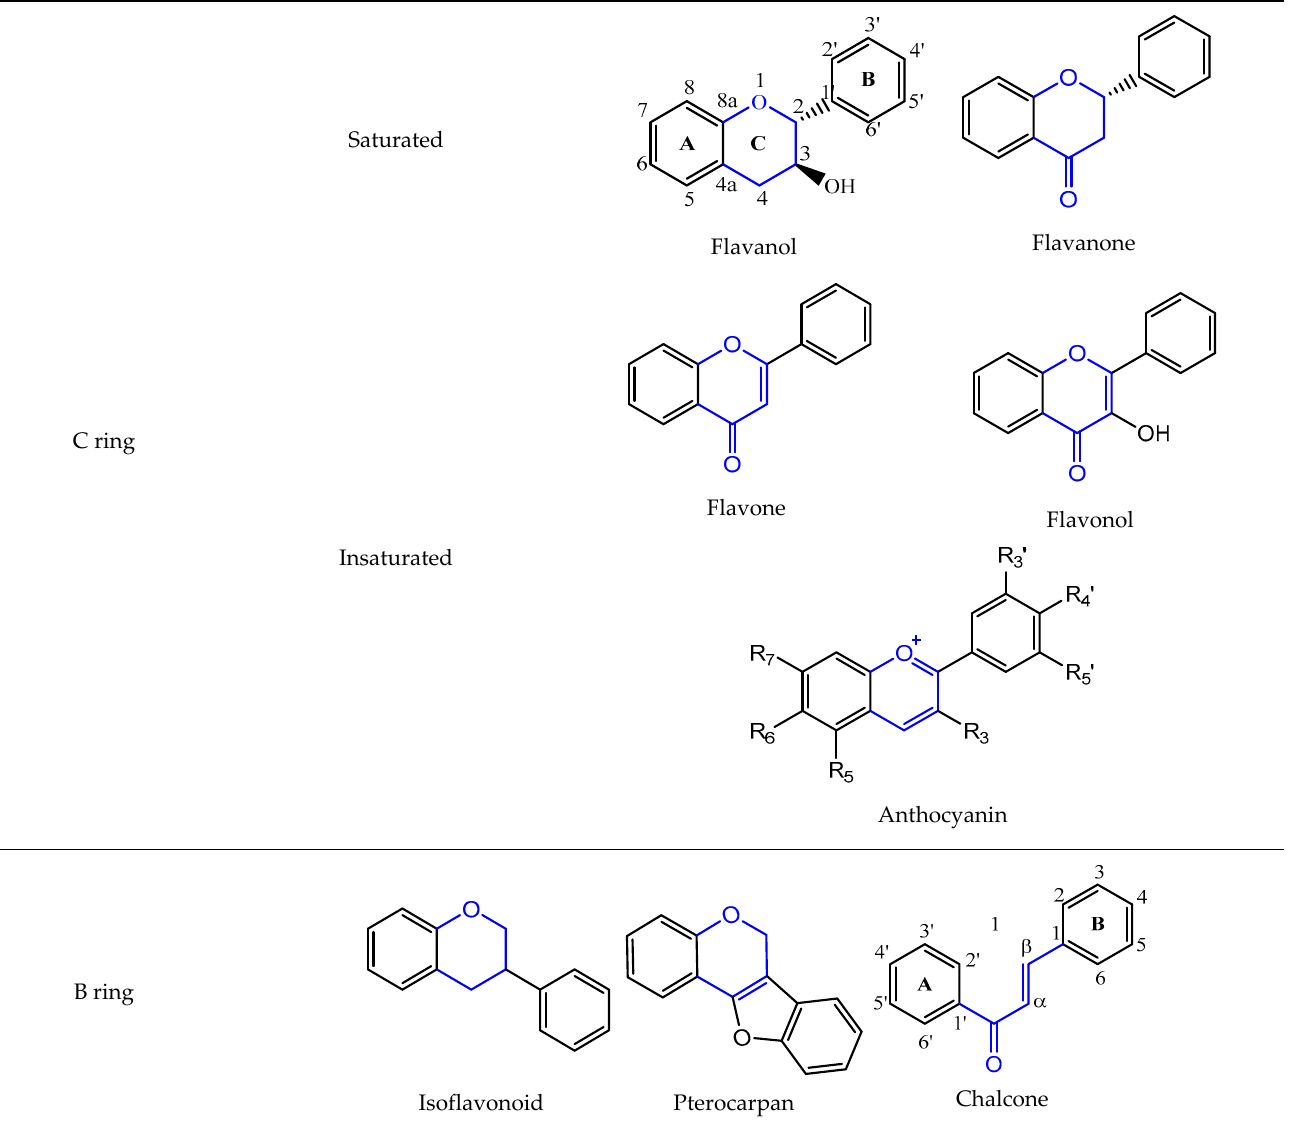
Table 1. Basic skeleton structure of classes of flavonoids.